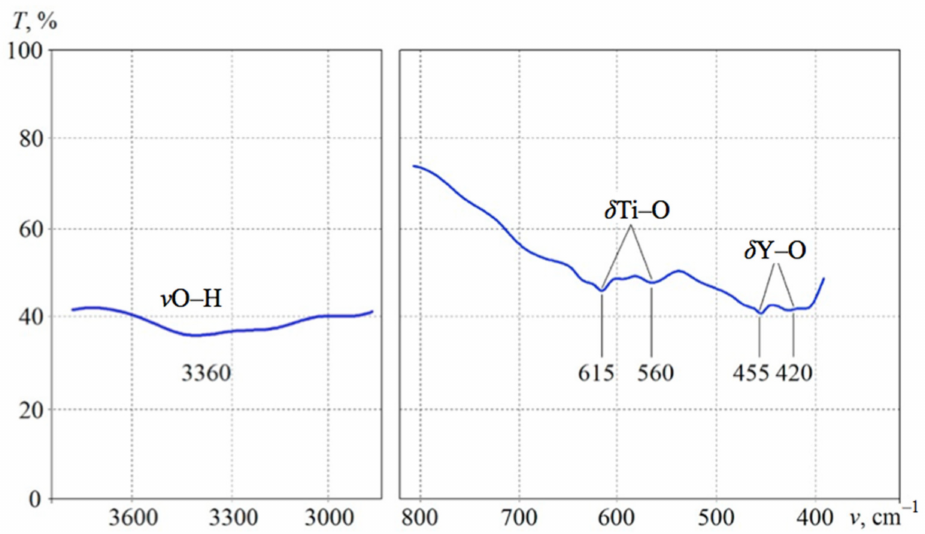
Figure 3. Important areas of IR absorption spectrum of the sample after 25 h of calcination at 1150 ◦